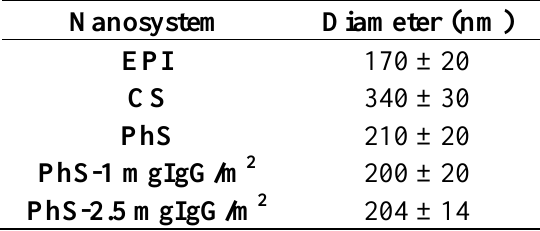
Table 1. Particle size of the different lipid nanocapsule and immuno-nanocapsule systems.